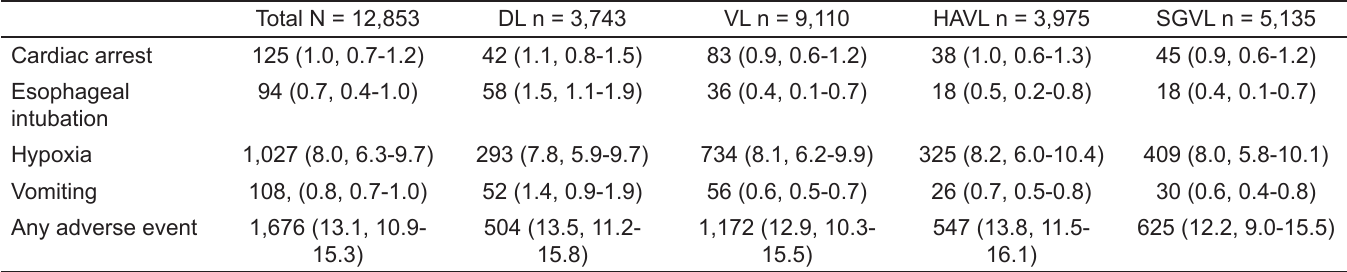
Table 5. Adverse event rates during first-pass intubation attempts for DL, VL, HAVL, and SGVL* among difficult airways. Total N =